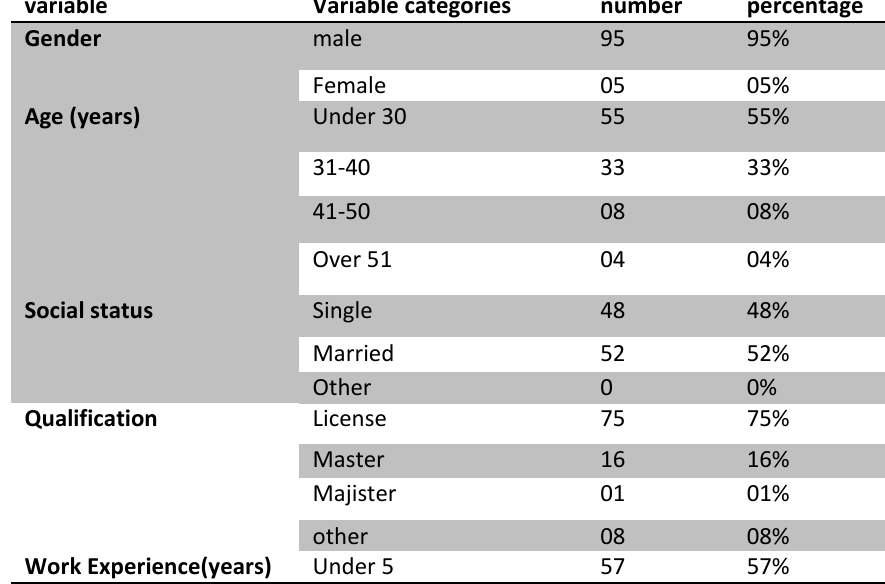
Table2 .Socio-demographic